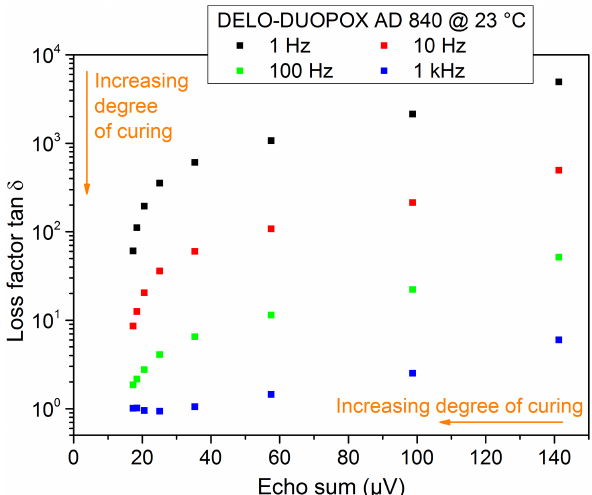
Figure 21. Comparison of the loss factor from DEA measurements and echo sums from NMR experiments at the same times for the 2C adhesive (DELO-DUOPOX AD840) cured at room